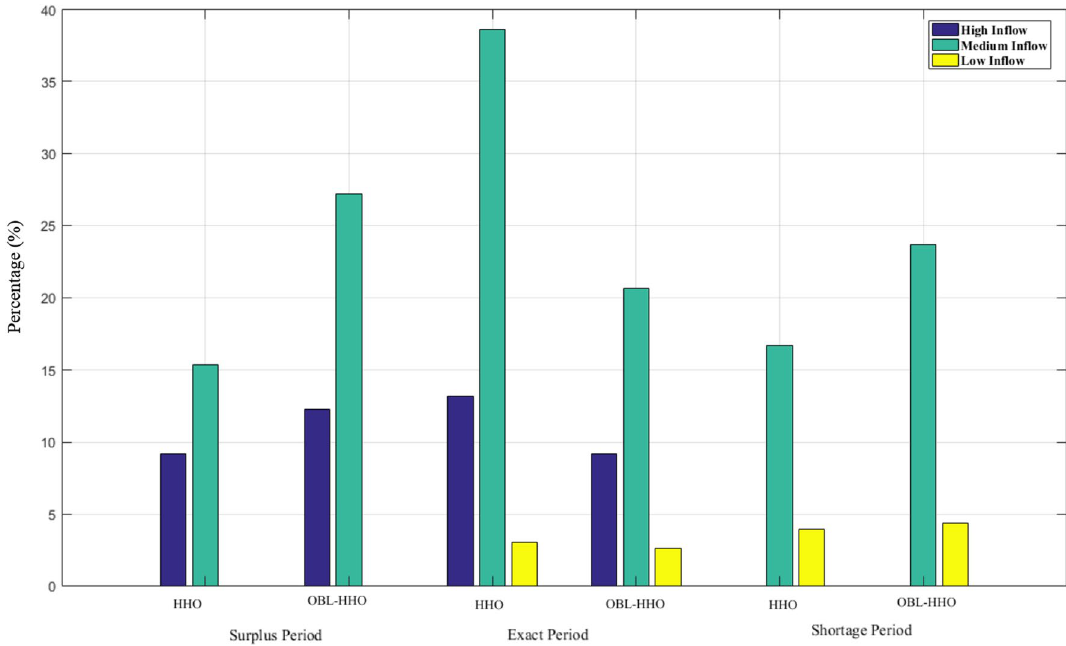
Figure 6. Periodic Reliability Performance in percentage classified according to inflow categories.